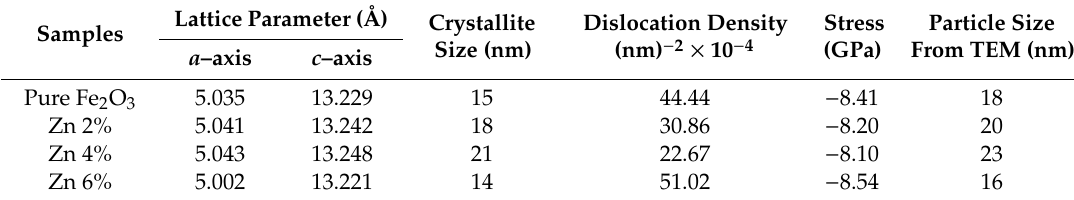
Figure 2. X-ray di ff raction pattern of pure Fe 2 O 3 , Zn 2%, Zn 4% and Zn 6% nanoparticles. Table 1. Structural parameters of pure Fe 2 O 3 , Zn 2%, Zn 4% and Zn 6% synthesized